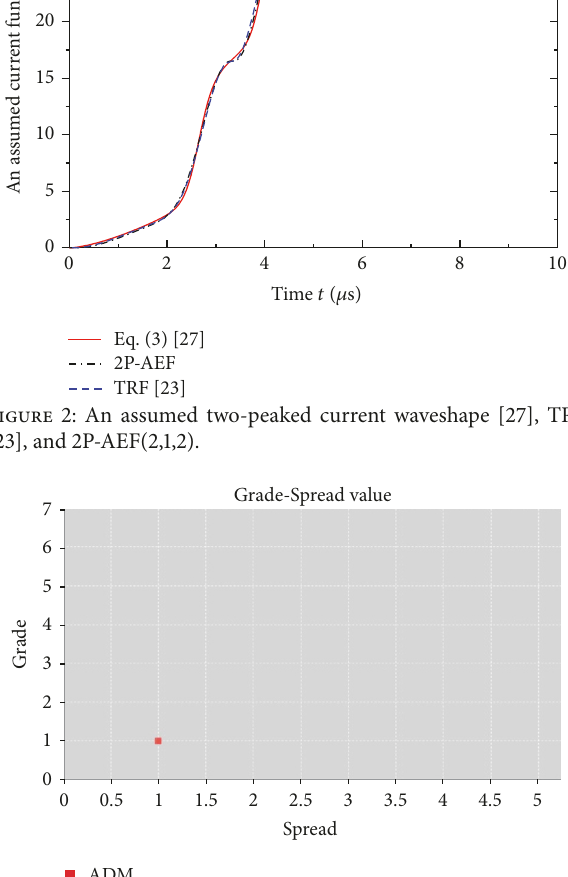
Figure 3: Grade-Spread value obtained by FSV applied to the assumed current [27] and its approximation by 2P-AEF(2,1,2) using GA for parameters